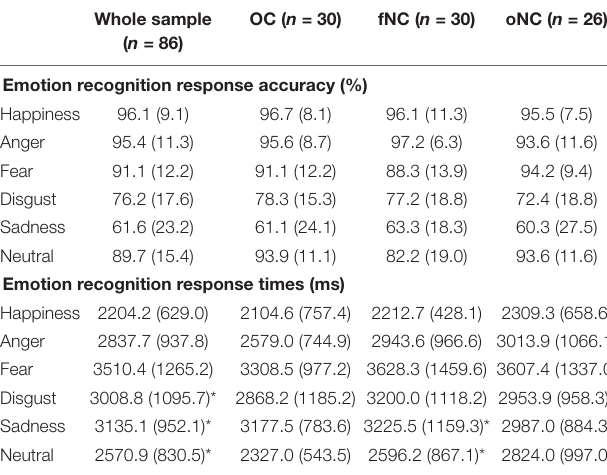
TABLE 2 | Emotion recognition performance (in percent) and response times (in ms) across the whole sample and for the individual hormonal groups (presented as mean and standard